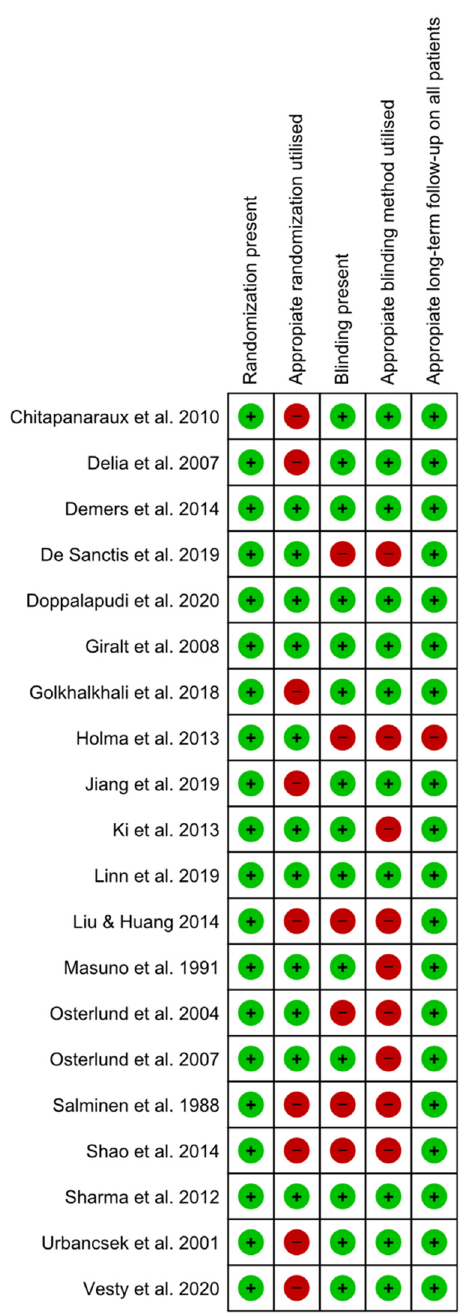
Figure 2. Risk of bias summary using the Jadad Scale for each included study.